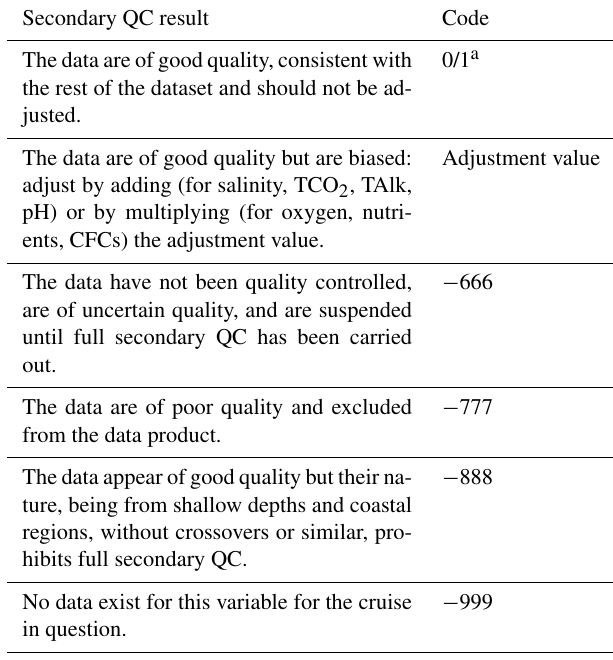
Table 5. Possible outcomes of the secondary QC and their codes in the online adjustment